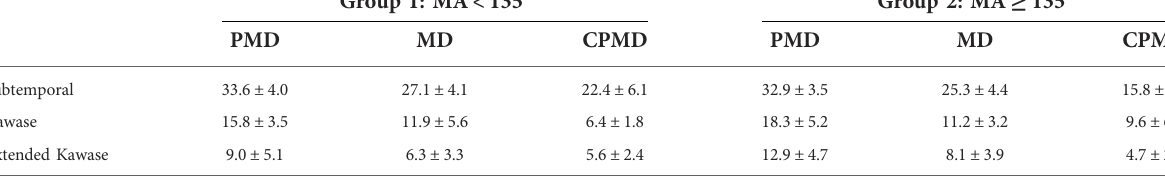
MA, manipulation angle; PMD, para-middle distance; MD, middle distance; CPMD, para-middle distance in the